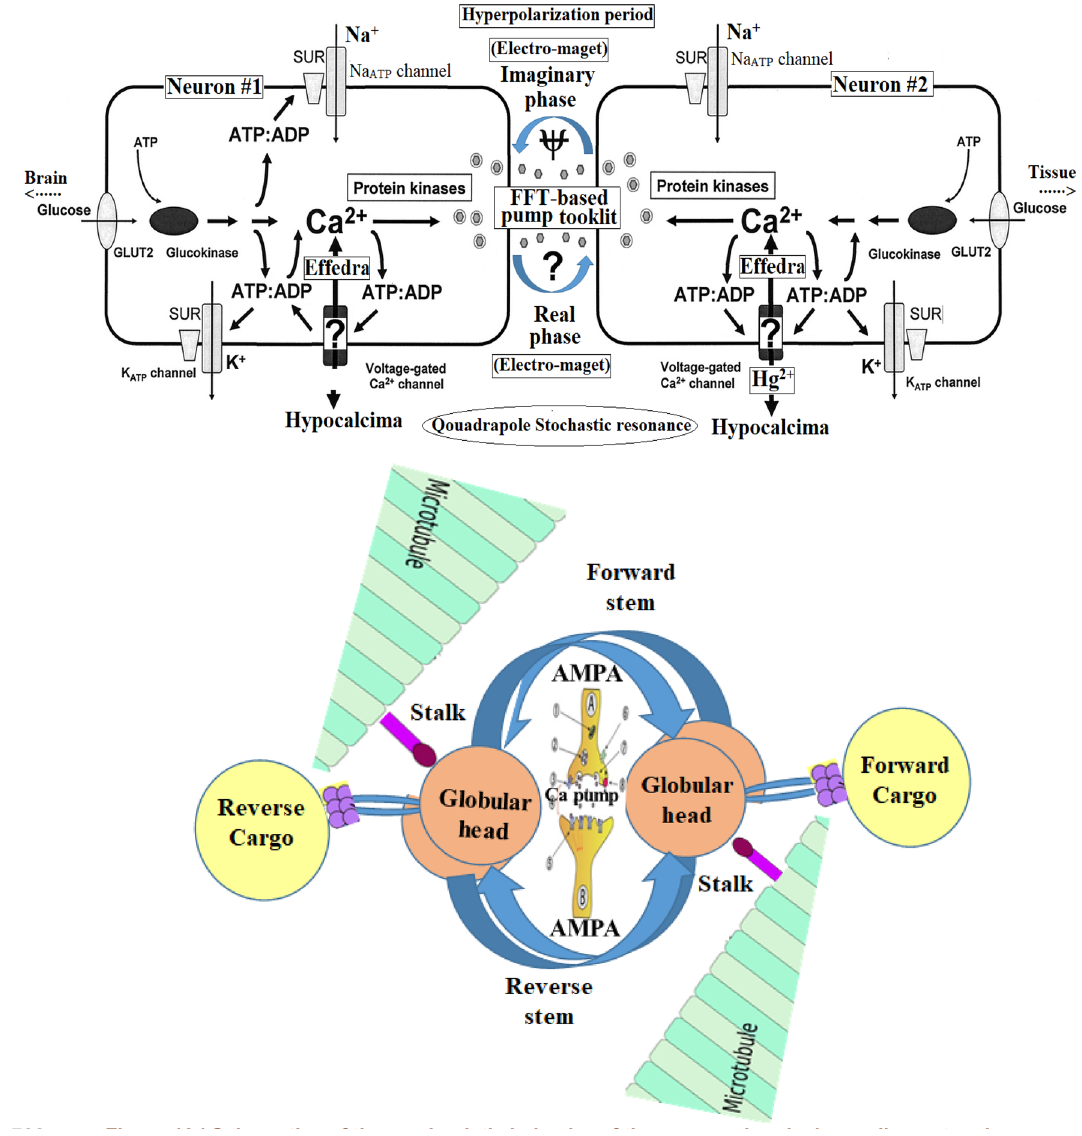
Figure 10. Schematics of the mechanistic behavior of the neuron electrical recycling